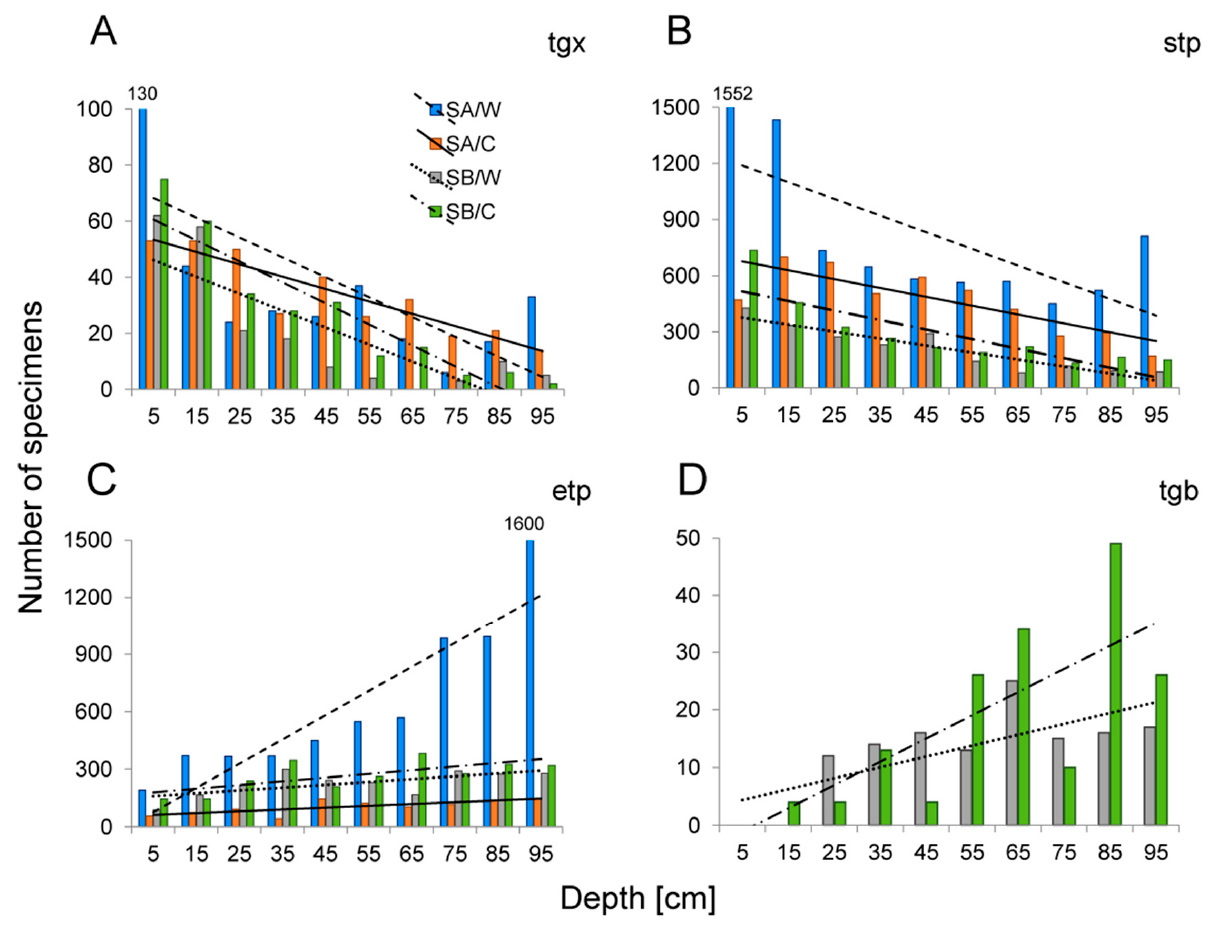
Figure 4. Vertical distribution of troglogroups along the depth gradient at both sites (SA, SB) in two periods; W—warm period, C—cold period, ( A ) tgx—trogloxenes, ( B ) stp—subtroglophiles, ( C ) etp—eutroglophiles, ( D ) tgb—troglobionts, Notice the different scaling of the second axis in the individual graphs.